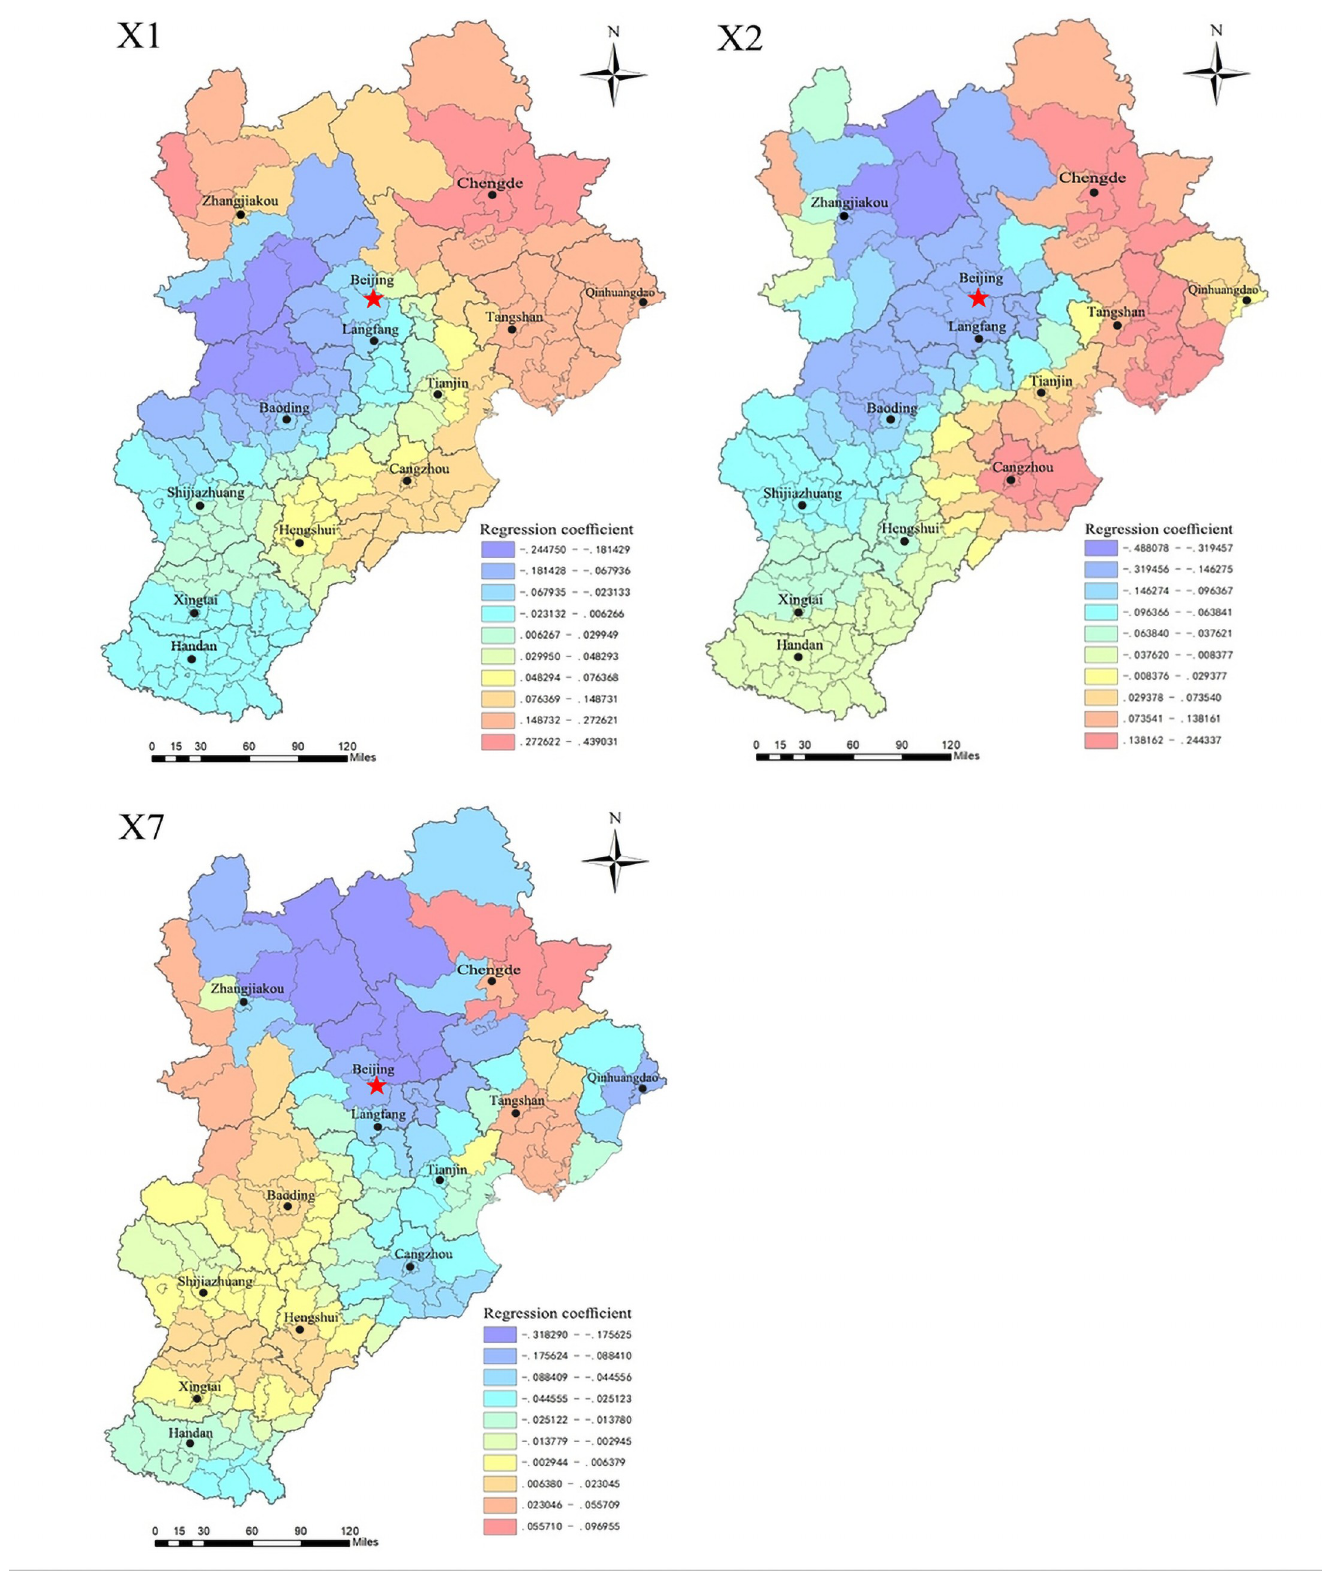
Fig 8. Regression diagram of indicators with weak correlation to residential land prices. https://doi.org/10.1371/journal.pone.0256710.g008 PLOS ONE | https://doi.org/10.1371/journal.pone.0256710 September 1,